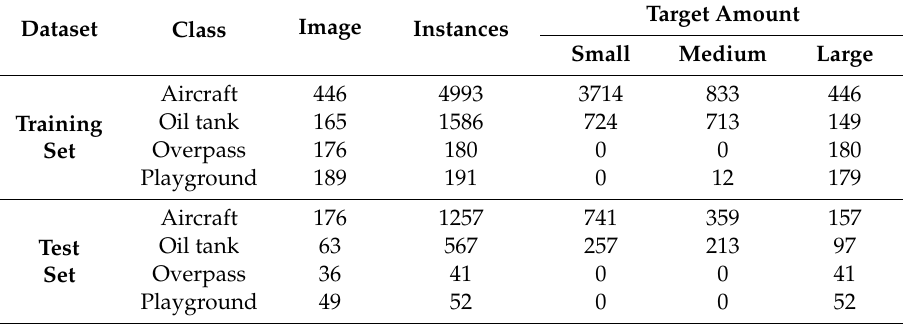
Table 5. Remote sensing object detection (RSOD) dataset statistics.